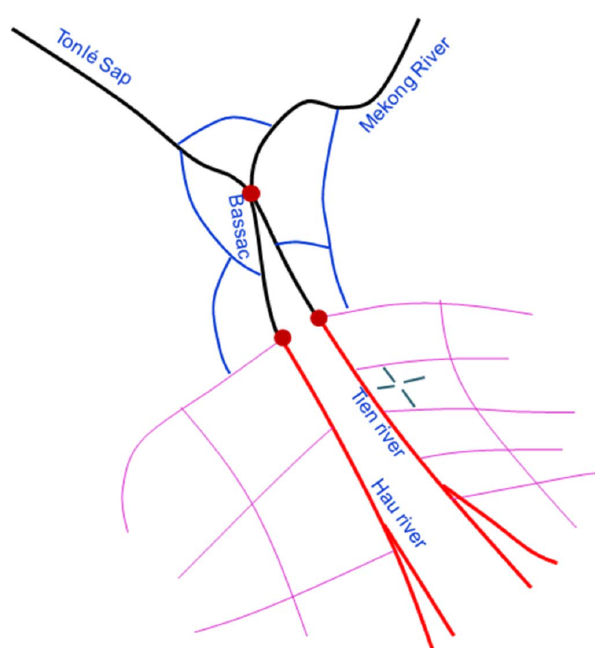
Fig. 6. Scheme of the roughness classification of channels and : black for Mekong and Bassac in Cambodia, red for Tien and Hau river and major channels in Vietnam, blue for Cambodian flood- plains, green for Vietnamese floodplain compartments and magenta for the remaining channels in the Vietnamese delta (cf. Table